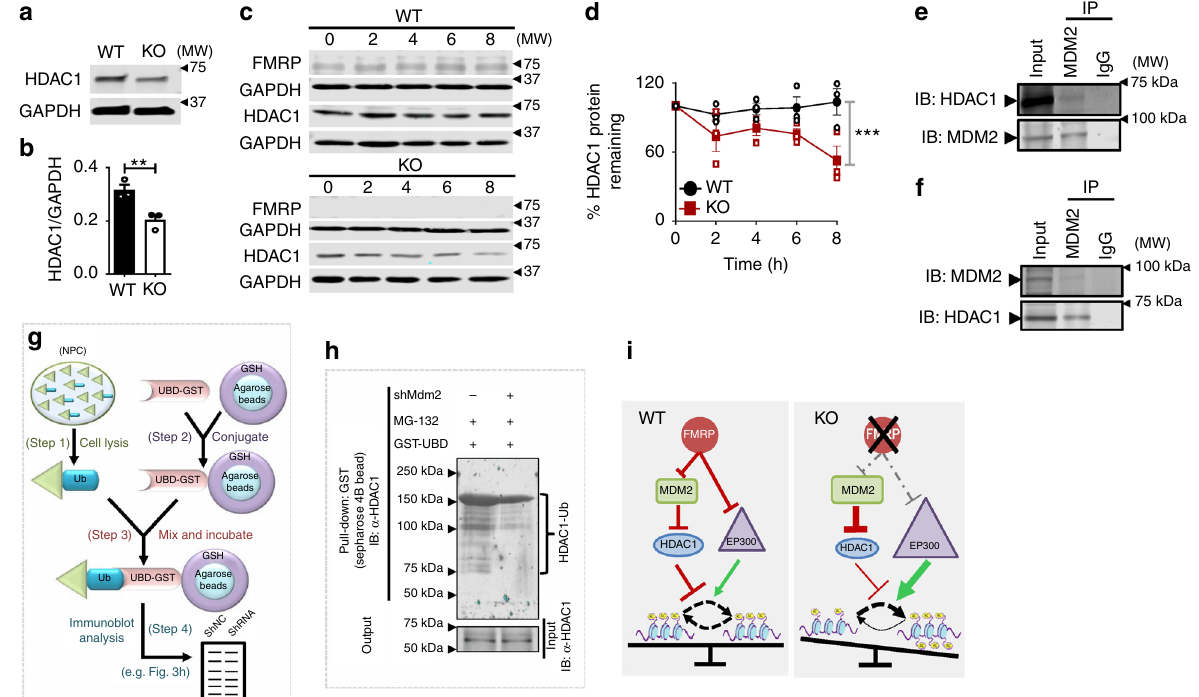
Fig. 3 FMRP maintains HDAC1 protein levels in NPCs of 6-month-old mice. a , b Western blot analyses of HDAC1 protein levels in WT and Fmr1 KO 6-mo NPCs ( n = 3). c , d HDAC1 protein stability in WT and Fmr1 KO NPCs treated with the protein synthesis inhibitor cycloheximide (CHX) over an 8 h period. Two-way ANOVA ( n = 3, F (4, 20) = 17.86, *** P < 0.001; Time × genotype interaction, F (4, 20) = 2.53, P = 0.0727; Time, F (4, 20) = 2.006, P = 0.1324). Note that FMRP protein levels in WT cells did not change during the treatment. e , f Co-immunoprecipitation analysis showed that endogenous HDAC1 physically associated with endogenous MDM2 in 6-mo NPCs. g Work fl ow for detection of ubiquitination of HDAC1 using GST-labeled ubiquitin-binding domain (UBD) pull down. h GST-UBD pull down of NPCs with MDM2 knockdown ( + shMdm2) and control ( − shMdm2) followed by western blotting with a HDAC1 antibody showing that NPCs with reduced MDM2 levels also had reduced ubiquitination of HDAC1. Cells were treated with MG132 to inhibit proteasome degradation of ubiquitinated proteins. i Schematic models of FMRP balancing histone acetylation through regulation of MDM2-HDAC1 and EP300 pathways. ** P < 0.01, *** P < 0.001, except for Fig. 3d, Student ’ s t -tests were used for data analyses. Data are presented as mean ±